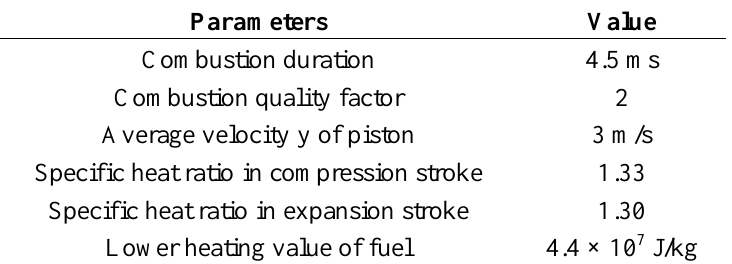
Table 2. Parts of simulation parameters of the single-piston engine generator.